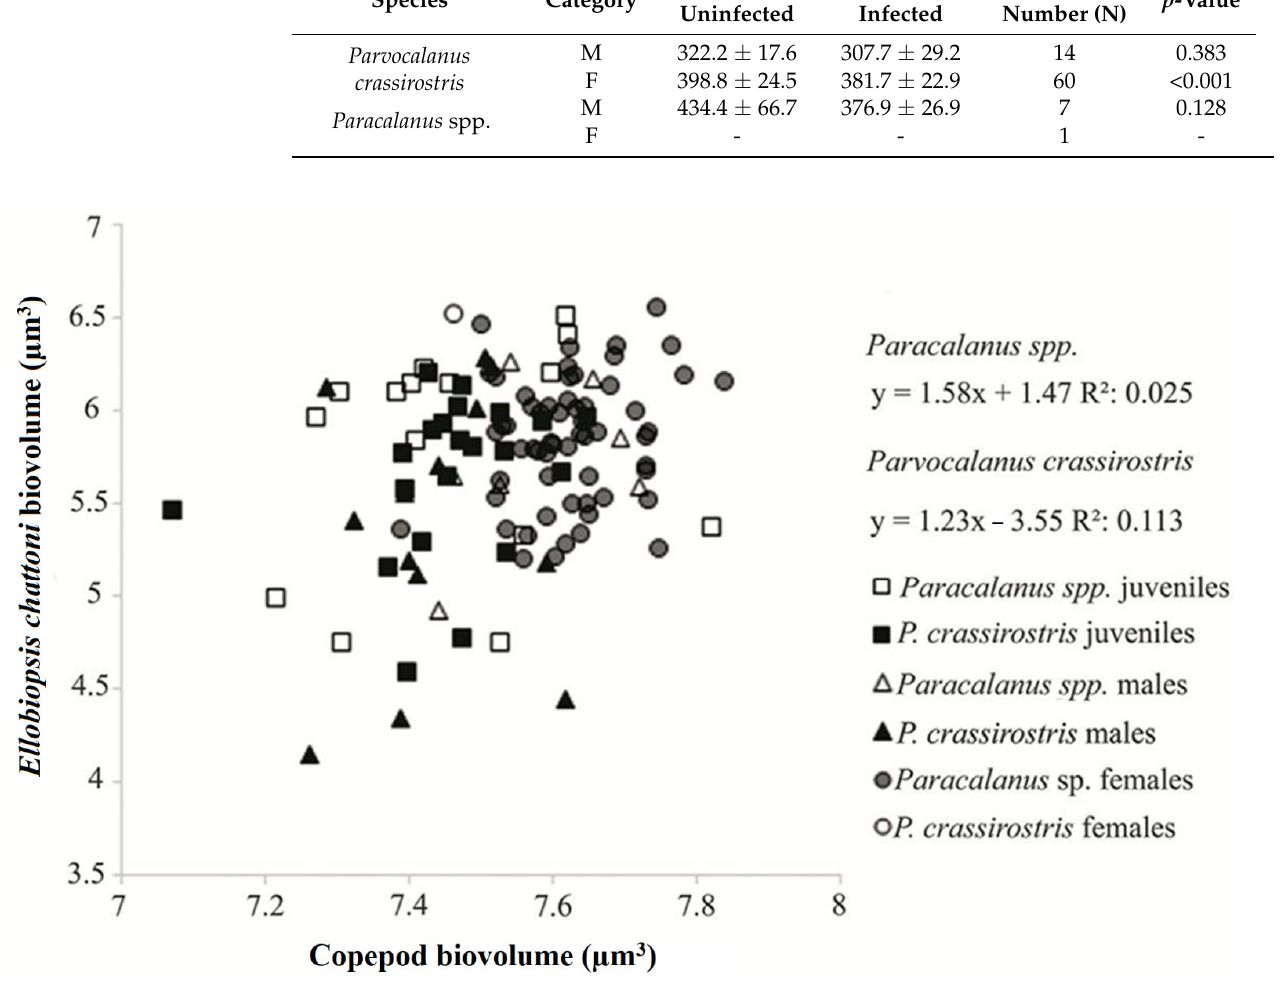
Table 3. Results of the Mann–Whitney test comparing the prosome length ( μ m) between uninfected and infected copepods for adult males and females of Parvocalanus crassirostris and Paracalanus spp. F: adult females; M: adult males. Mean ± S.D. Species Category